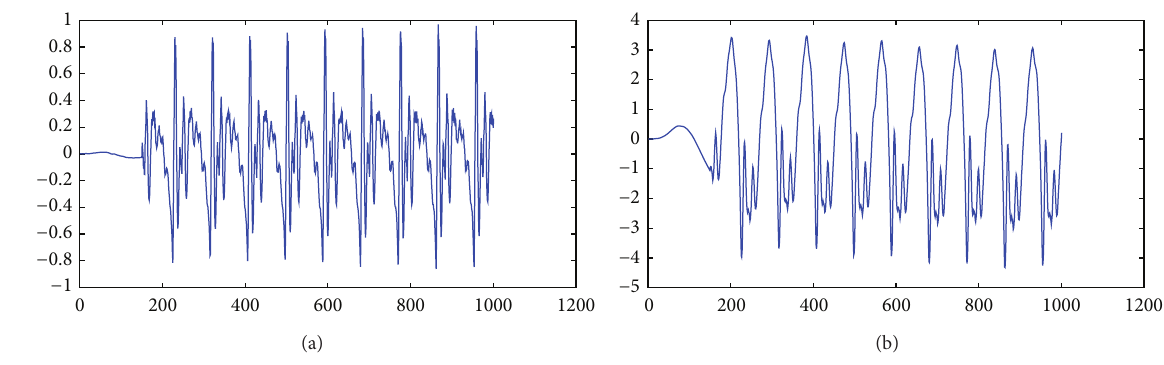
Figure 7: SIMULINK model of IAIF algorithm.